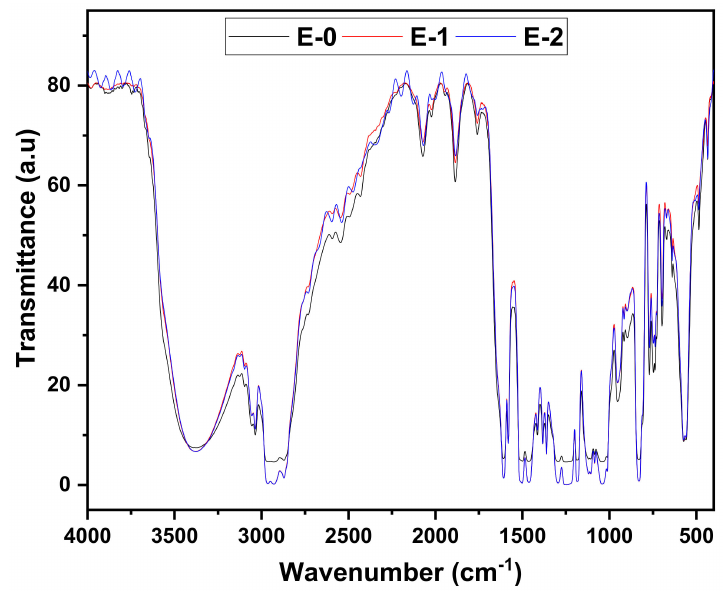
Figure 1. FTIR spectrum of formulation with PA-450 hardener.